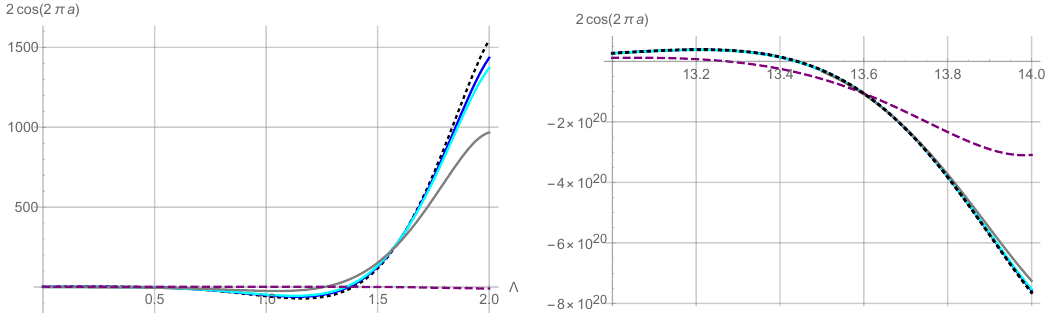
Figure 4. The graphics present the dependence of 2 cos(2 πa ) on Λ . The blue is for p = 0 . 1 , cyan for p = 0 . 2 , gray for p = 0 . 5 and purple dashed for p = 2 . The black dotted line is the asymptotic curve given by (3.32). Notice that in the second picture Λ reaches 14 corresponding to q = 38416